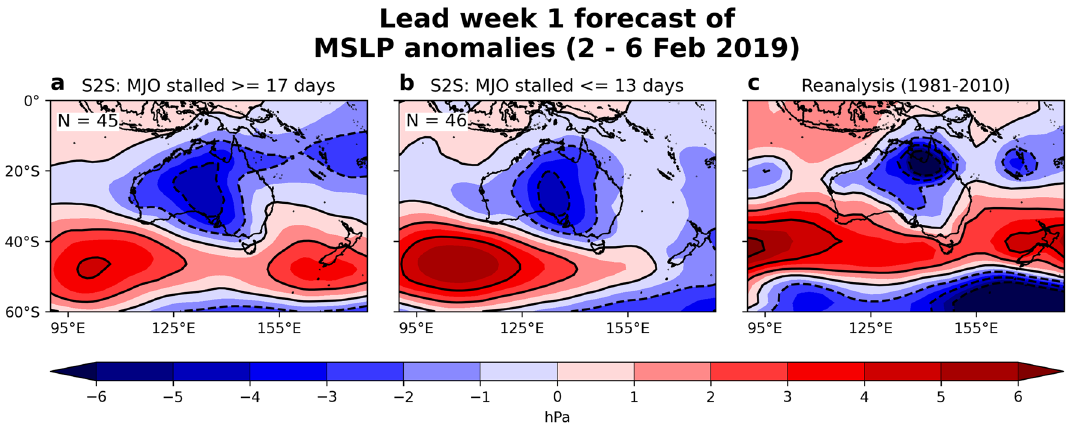
Figure 6. A comparison of daily MSLP anomalies averaged over the 2–6 February 2019 from reanalysis and lead week 1 forecasts from S2S multi-model experiment ensembles. Shown are the weighted multi-model ensemble average of lead week 1 forecasts of daily MSLP anomalies from six S2S models (ECCC, ECMWF, ISAC-CNR, JMA, Météo-France, NCEP) where individual member predictions showed ( a ) an active